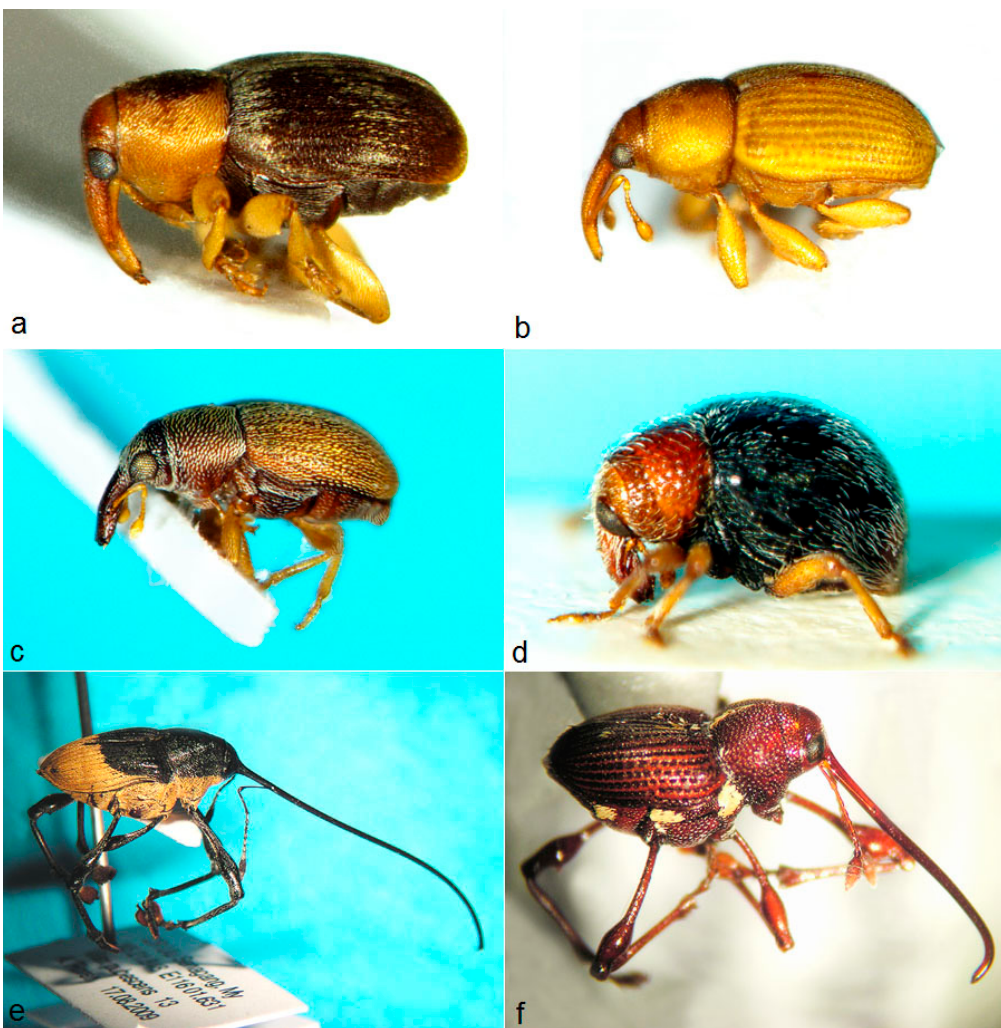
Figure 4. Curculioninae I. Parimera spec. ( a ) and two unknown small genera of Acalyptini ( b , c ); the latter cf. Niseida ( c ); a scymnine-like, red-and-black coloured Demimaea species with trifid hairs ventrally and at the base of the elytra ( d ) and two long-nosed Curculionini species ( e , f ); one of them ( f ) a Pseudoculio species.